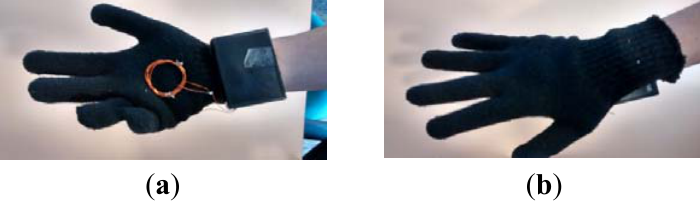
Figure 4. Example of hand movement with our cybernetic glove, ( a ) palm and ( b ) back